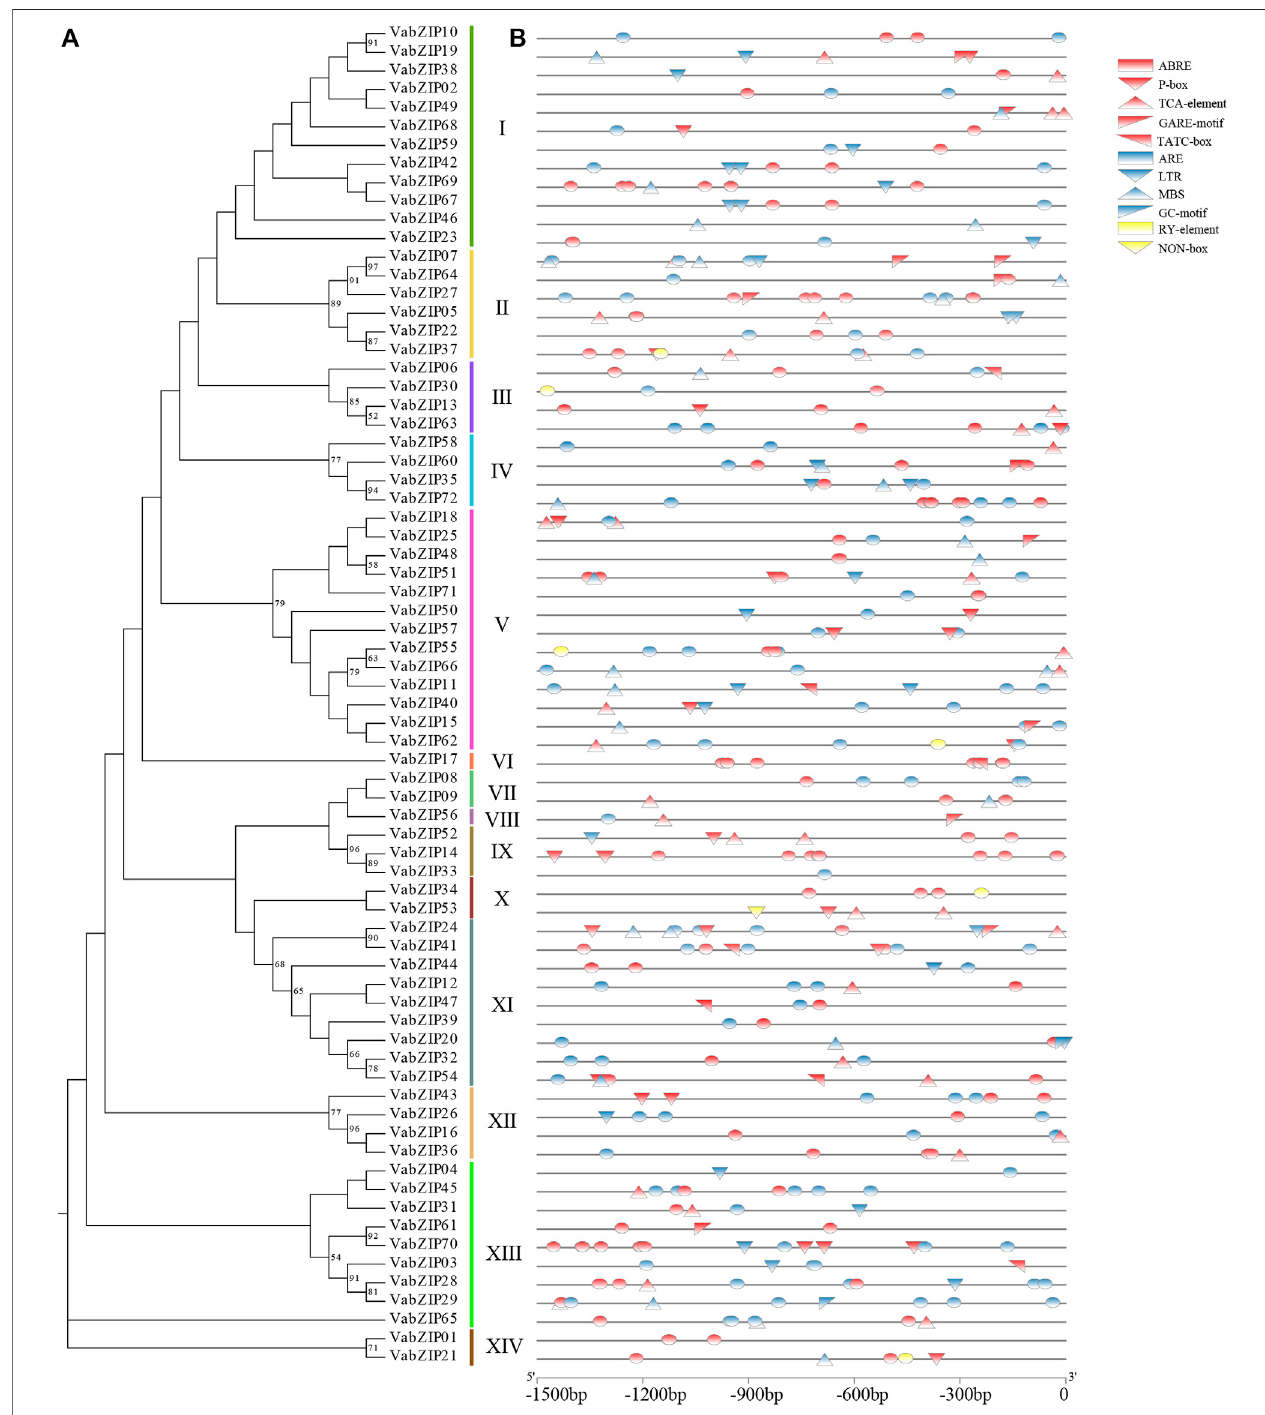
FIGURE5| Cis -elementsof VabZIPs. (A) Evolutionaryanalysisof VabZIPs. (B) Cis -elementsof VabZIPs. Theredmodelsrepresentthehormone-relatedelements. The blue models represent the stress-related elements. The yellow models represent the elements in germination.